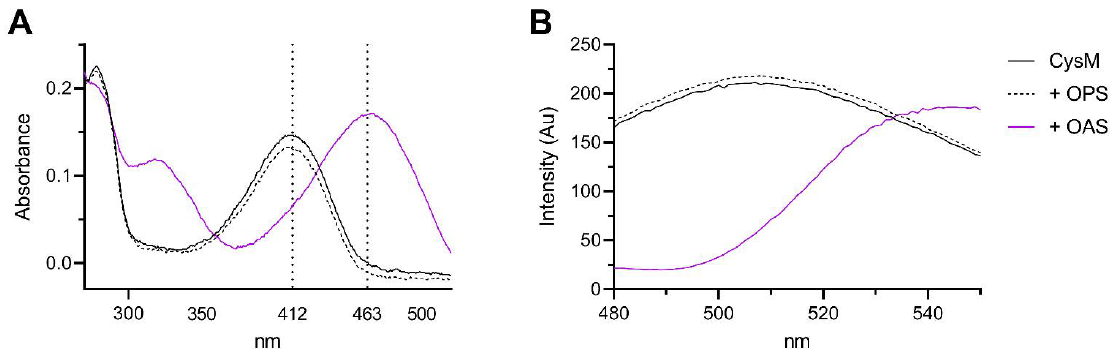
Figure 3. First half-reaction of purified CysM with sulfur acceptors OPS and OAS. ( A ) UV-vis scan of CysM generating the aminoacrylate intermediate (463 nm maximum) and reduction in PLP absorbance (412 nm maximum) with OAS, but not OPS. ( B ) A large shift in the emission spectra of the CysM PLP cofactor (excited at 412 nm) occurs with the addition of OAS, but not OPS.